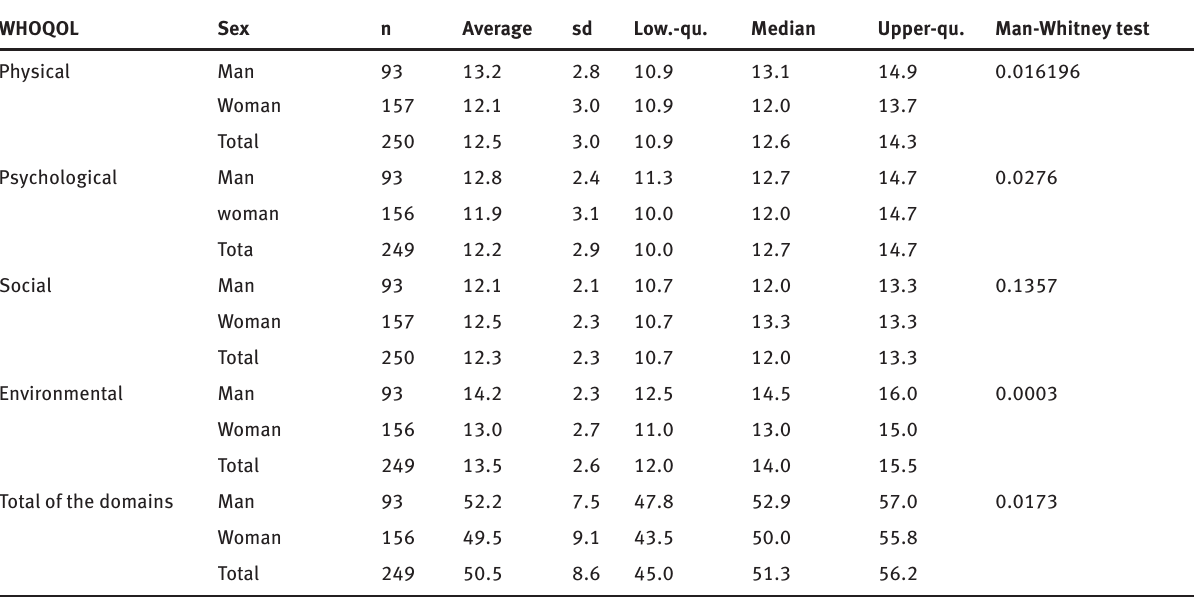
Table 8: Quality of life of those surveyed as per WHOQOL-BREF split into domains and sex